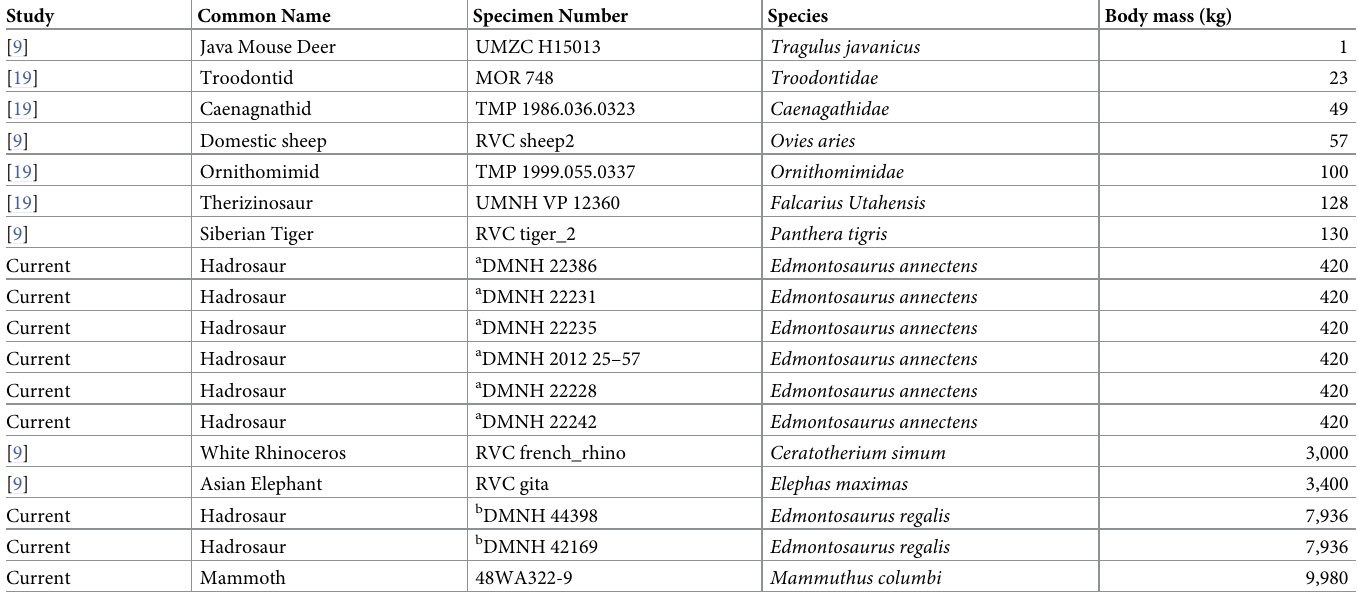
Table 1. Species used in this